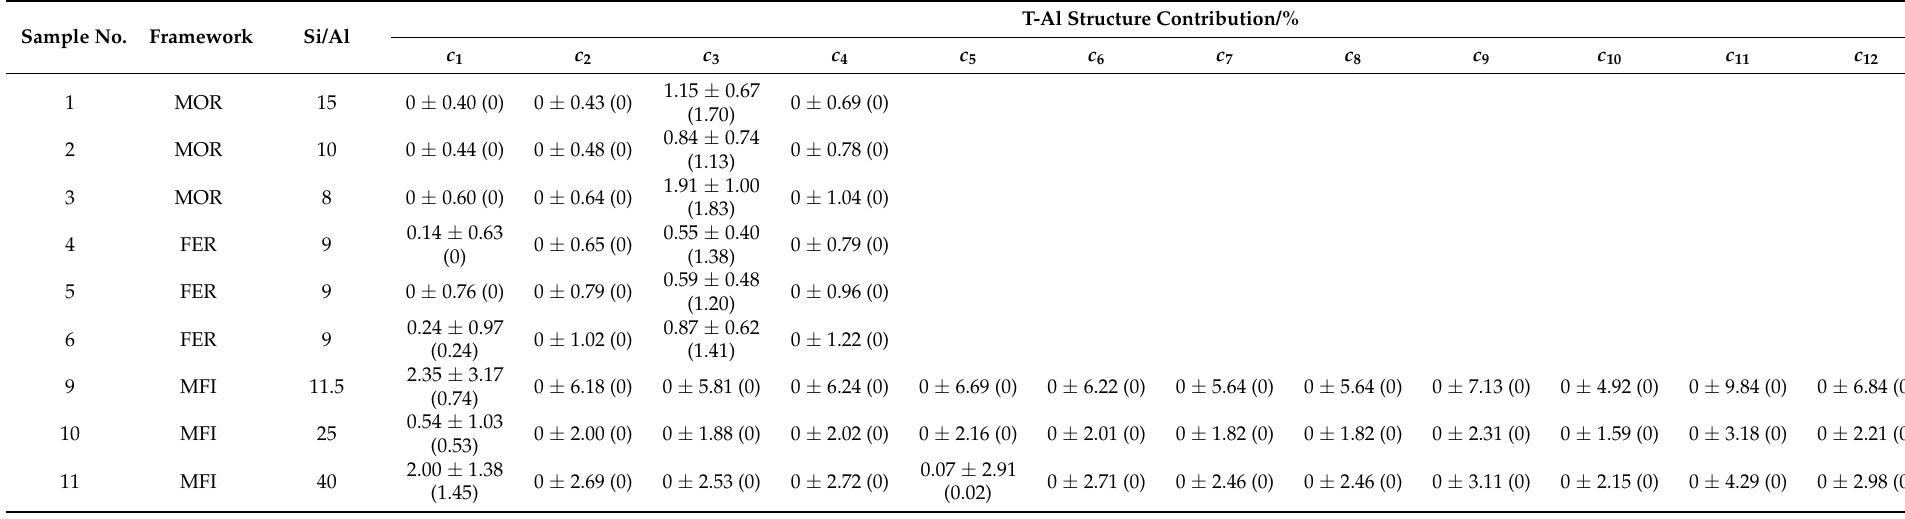
Table 4. Values of the c x parameters calculated from the Equation (2) together with standard deviations and t -values (in parentheses). Dash (–) denotes that no satisfactory fit was found with concerned